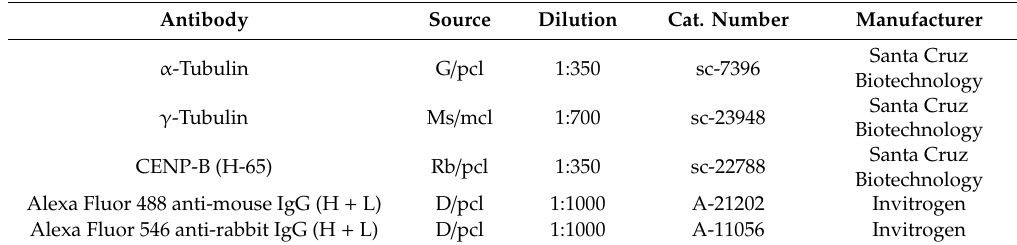
Santa Cruz Biotechnology A-11056